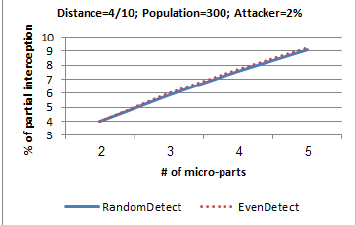
Figure 3. Number of connections at least one part was captured.